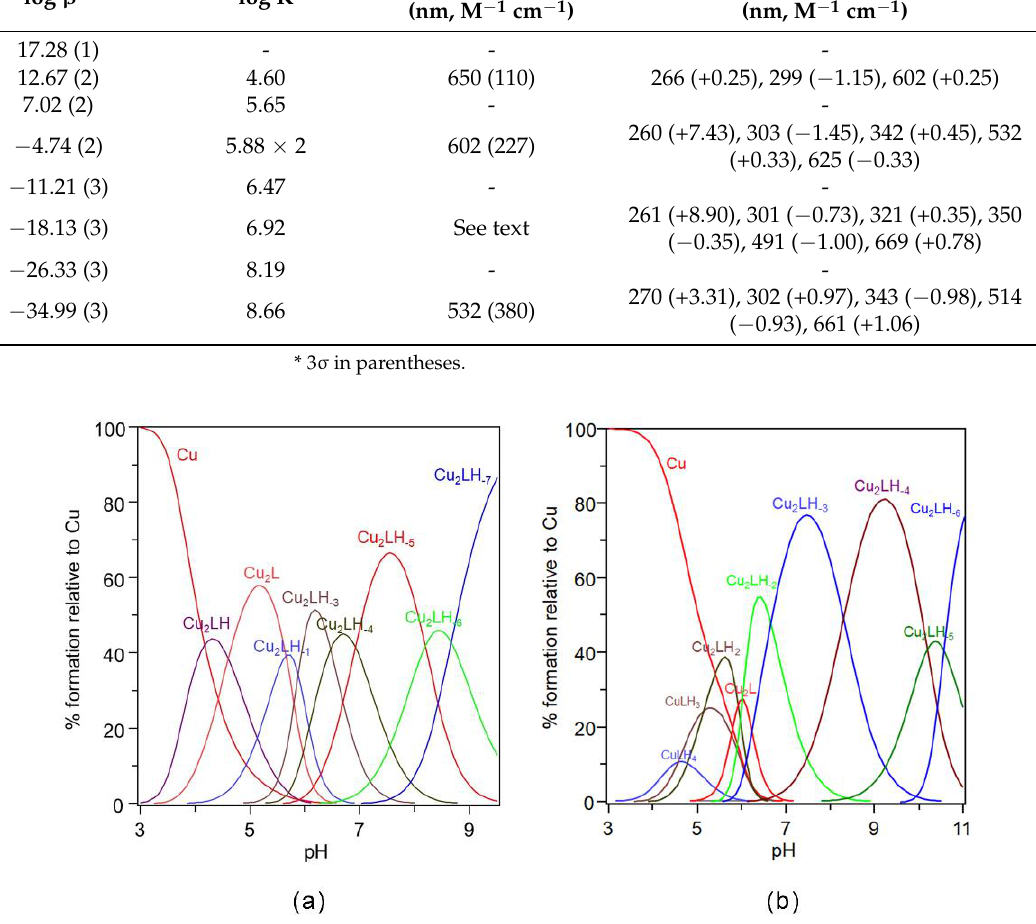
Figure 3. Species distribution of copper(II) complexes with: ( a ) Ang1-17; and ( b ) AcAng1-17. [L] = 1 × 10 − 3 M; metal-to-ligand molar ratio of 2:1.